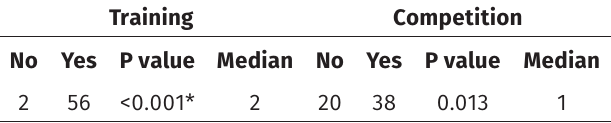
Table 2. Survey of Racket Sport Coaches on the use of Wearable Sensors during Training and Competition (Continuation). Would you willing for your athlete to wear a senor placed on the lower leg? Would you willing for your athlete to wear a senor placed on the shoe? Yes, in Training Would you willing for your athlete to wear a senor placed on the racket handle?